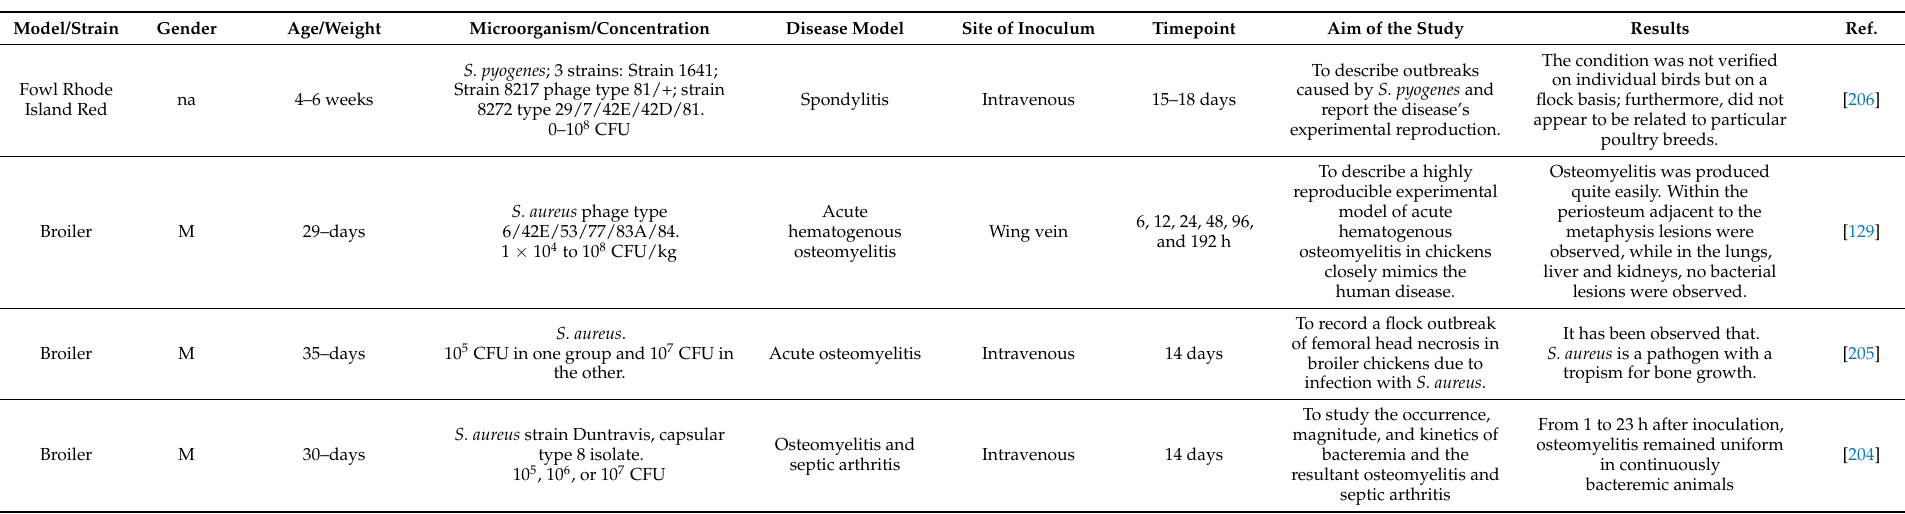
Table 5. Poultry models of orthopedic